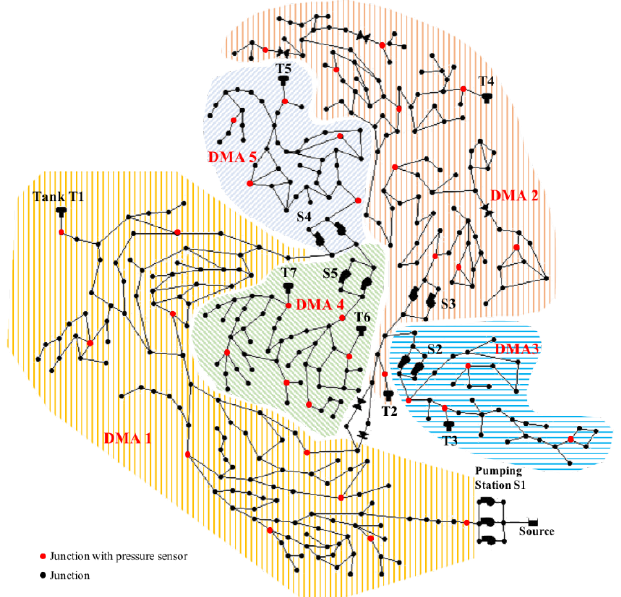
Figure 3. Layout of the C-Town